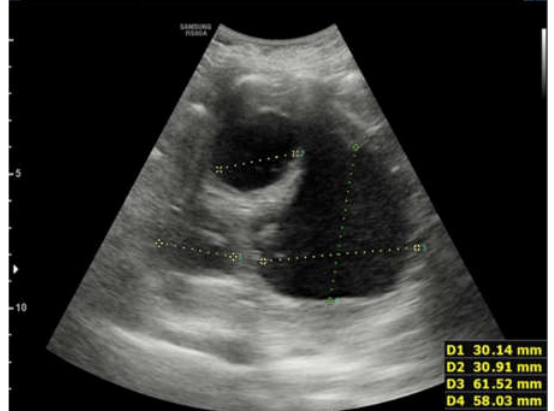
Figure 2. The first lung ultrasound performed on the first day after the admission to the hospital ward. The ultrasound showed a thickening of parenchyma of most of the right lung with multiple abscess formations inside, partly confluent, with fluid-corpuscular content and rounded appearance and an extensive pleural effusion at the right lung base.